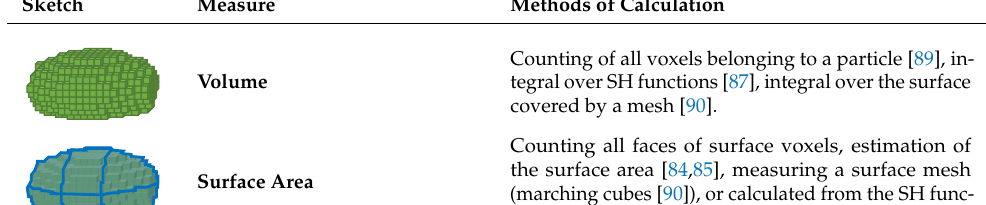
Table 1. Overview of common particle size measures, and their methods of calculation from the digital image data. The same measure can often be calculated in multiple ways, as listed in the right-hand column. SH refers to approximating the particle surface with spherical harmonics